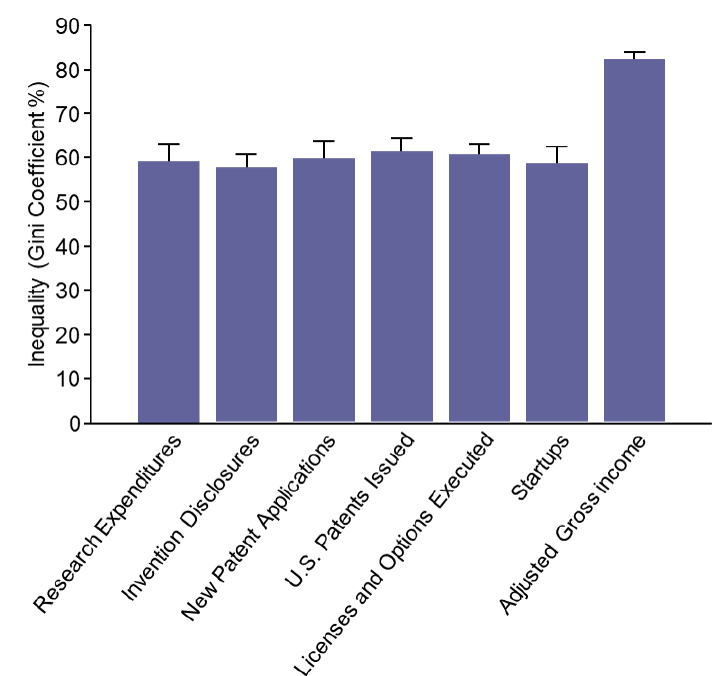
Figure 3. The Gini Coefficient for each stage in the commercialization pipeline, with G of 0% representing complete equality and G of 100% represents complete inequality. Error bars represent one standard deviation of uncertainty as estimated via jackknife resampling (Karagiannis & Kovacevic’, 2000; Yitzhaki,